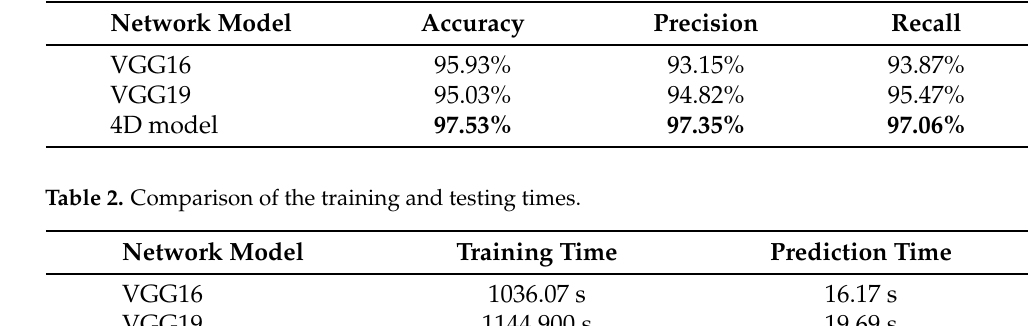
Table 1. Accuracy evaluation.